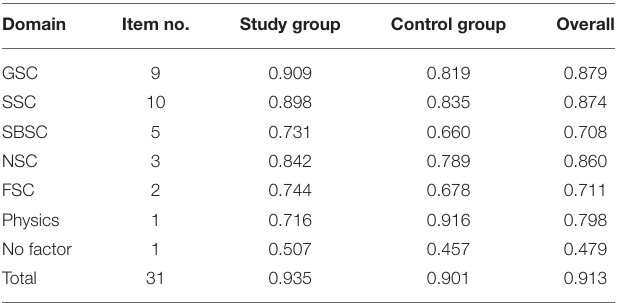
TABLE 5 | Total and domain scores of DAS 59 scale in patients with cleft lip.